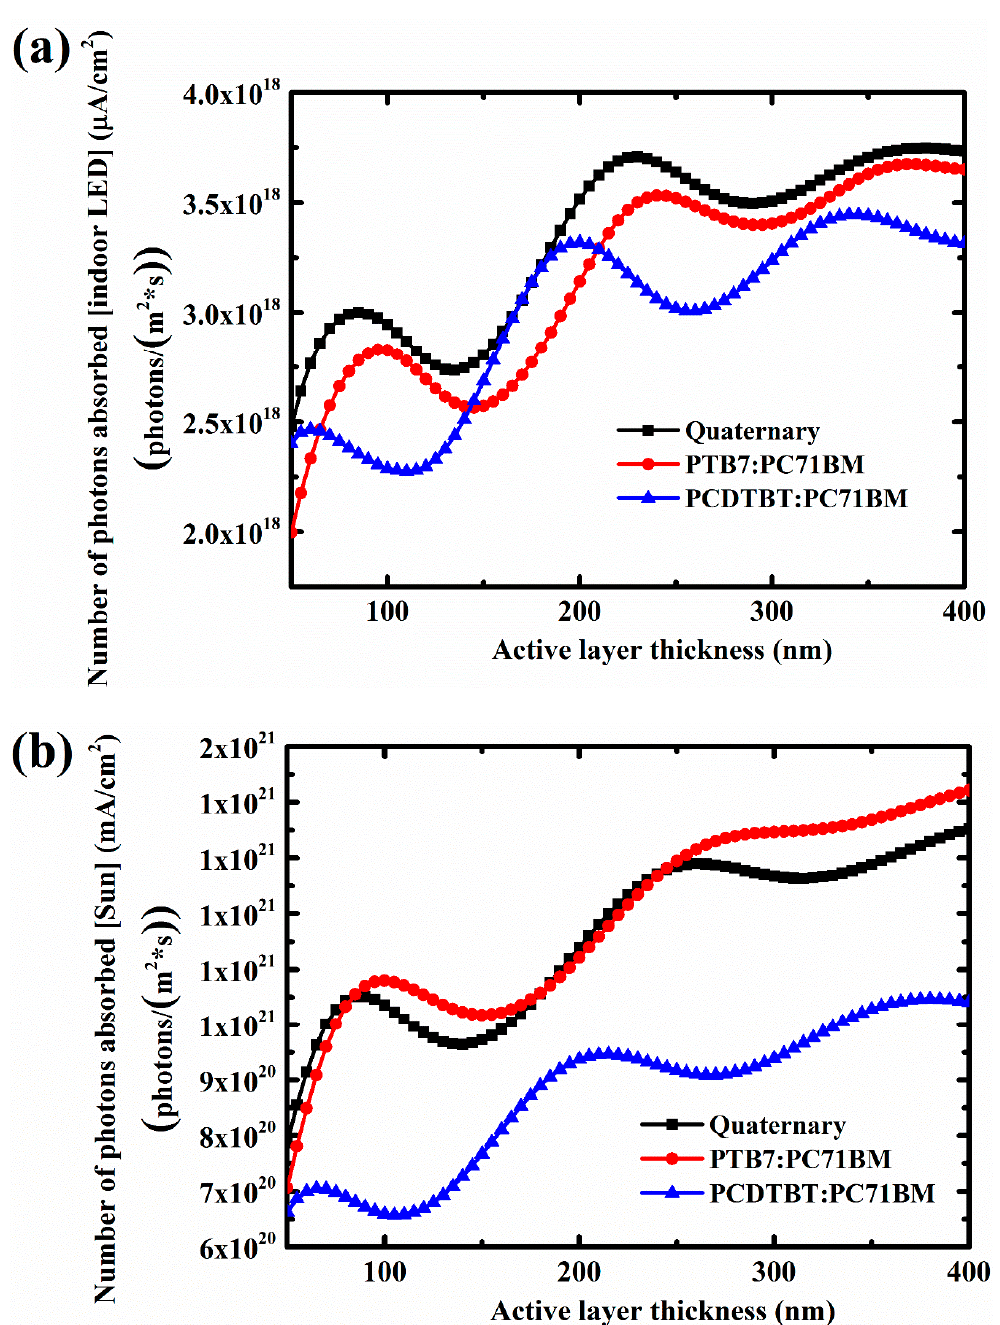
Figure 2. Assuming 100% IQE, the ideal short-circuit current density (J sc,ideal ) was simulated. ( a ) The number of photons absorbed (which directly relates to the J sc,ideal ) in quaternary and single BHJ photovoltaic cells under indoor LED illumination. ( b ) The number of photons absorbed in quaternary and single BHJ photovoltaic cells under AM1.5 G illumination.